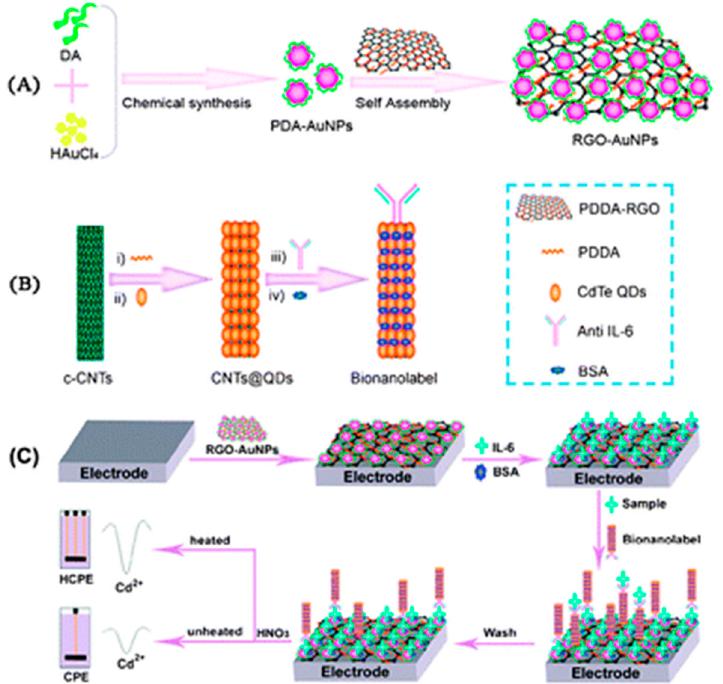
Figure 11. Schematic illustrations of ( A ) the preparation of RGO-AuNPs nanocomposite, ( B ) assembly procedure of CNTs@QDs-anti-IL-6 Ab bionanolabel and ( C ) fabrication and measurement process of the competitive immunosensor. Surface bound IL-6 and sample IL-6 compete for binding with the bionanolabel, and the depletion in the bound Cd 2+ is measured with stripping voltammetry on a heated SPCE, proportionate to the IL-6 concentration. Reprinted from [137] with permission from The Royal Society of Chemistry.